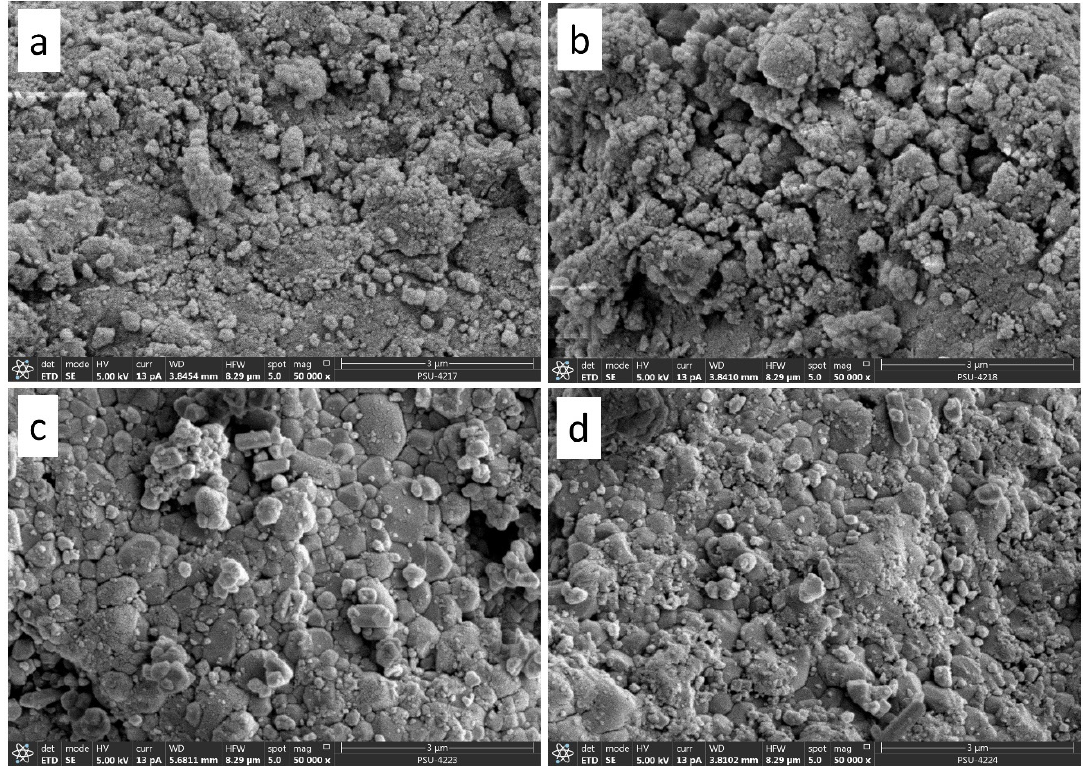
Figure 4. SEM images at 50,000× magnification for ( a ) Bio-cal-A, ( b ) Bio-cal-H, ( c ) Cal-A 900 °C 6 h and ( d ) Cal-H 900 °C 6 h.